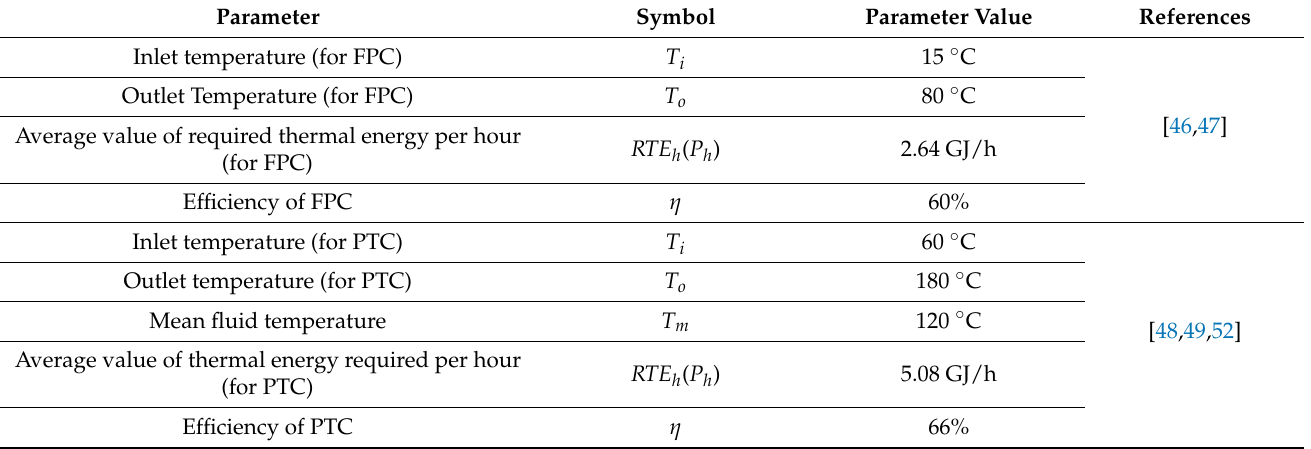
Table 5. Inputs for financial analysis of using a solar thermal system for SIPH in textile